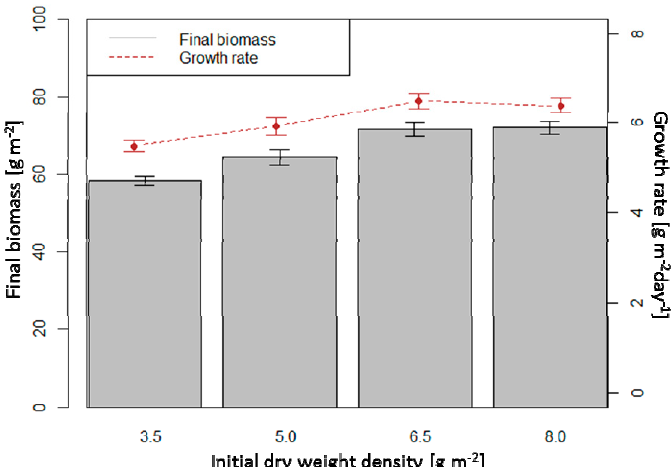
Figure 5. Final biomass and biomass growth rate (average of biomass increase per day over ten days) of H. pluvialis at different initial biomass densities after ten days of growth in a PSBR with a light intensity of 80 µmol photons m − 2 ·s − 1.